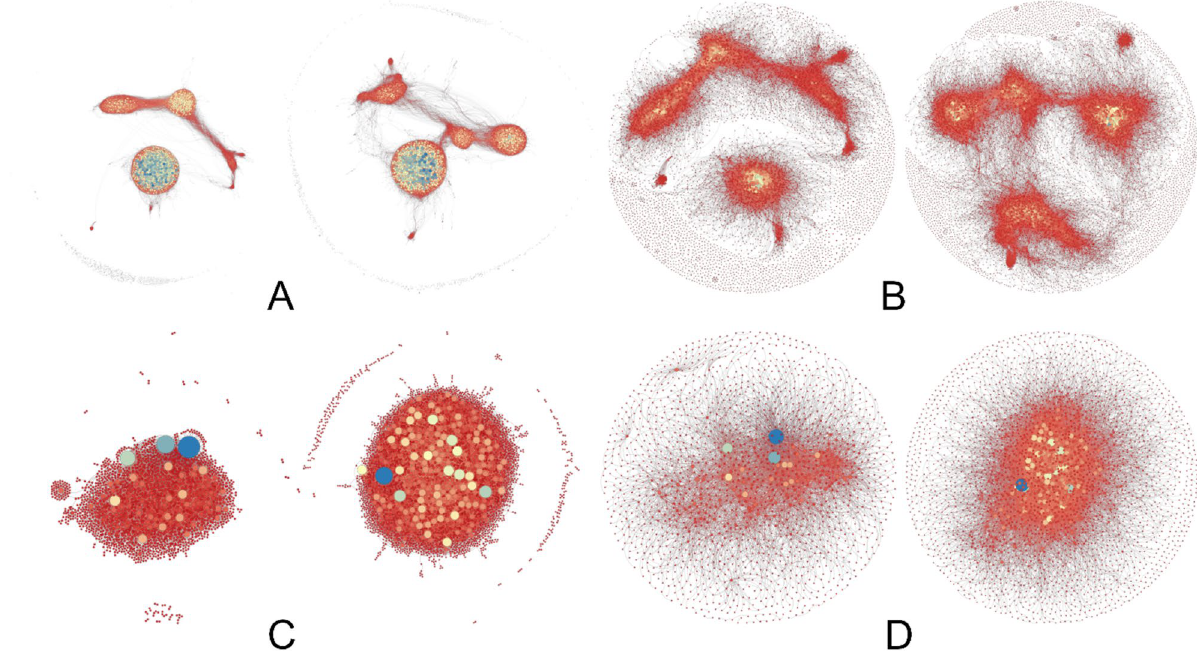
Figure 4. High correlation networks depicted by ForceAtlas2 ( a ,c) and Fruchterman-Reingold ( b , d ). For each figure, the network on the left shows correlations in parous, and the network on the right in nulliparous. Each probe is represented by a node, and when the correlation ρ between this probe and any other verifies abs(ρ) > 0.8, a link is depicted. In addition, the higher this value, the smaller the distance between the two linked probes. The size of each node/probe is proportional to the number of correlations verifying abs(ρ) > 0.8 that the probe presents with all the others. Color also varies (blue for nodes for higher number, yellow for intermediate, and red for lower). (a, b) High positive correlation networks, 1 < ρ ≤ 0.8, ForceAtlas2 (a), Frutcherman-Reingold (b). (c, d) High negative correlation networks, -1 < ρ ≤ -0.8, ForceAtlas2 (c), Frutcherman-Reingold (d). In all cases, the different network shapes and probe sizes and colors between groups are coherent with changes in the correlation structure after FFTP caused by variation in chromatin